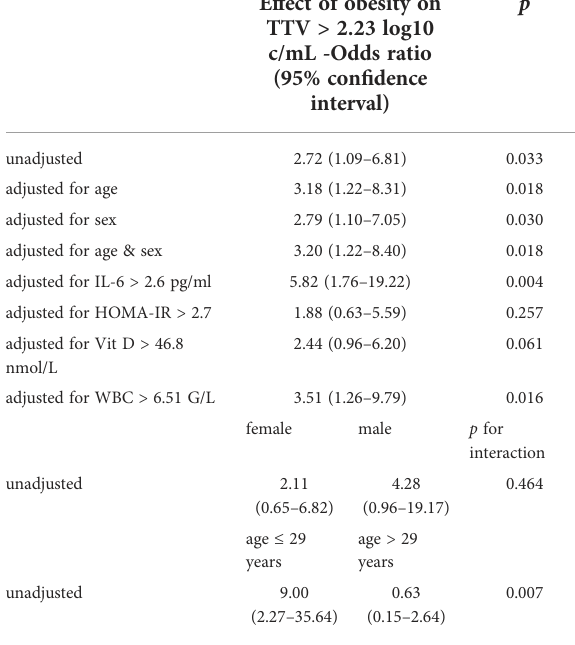
TABLE 3 Association between obesity and TTV levels above the median of 2.23 log10 c/mL in logistic regression analysis. Effect of obesity on TTV > 2.23 log10